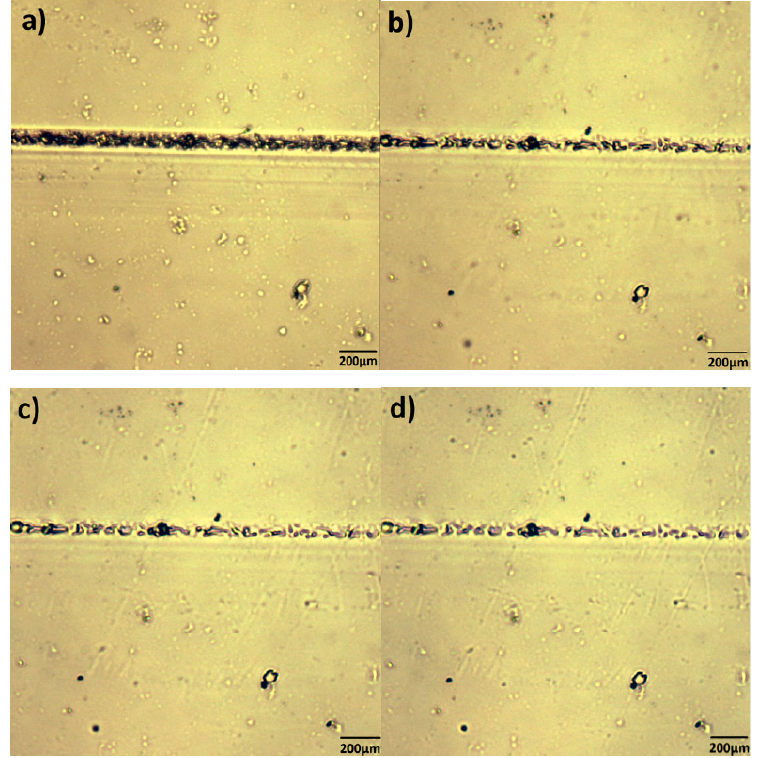
Figure 7. Hot stage polarized microscopic images of ( a ) knife-cutting film; ( b ) film after repairing at 60 °C for 24 h; ( c ) film after repairing at 60 °C for 48 h; ( d ) film after repairing at 60 °C for 72 h.